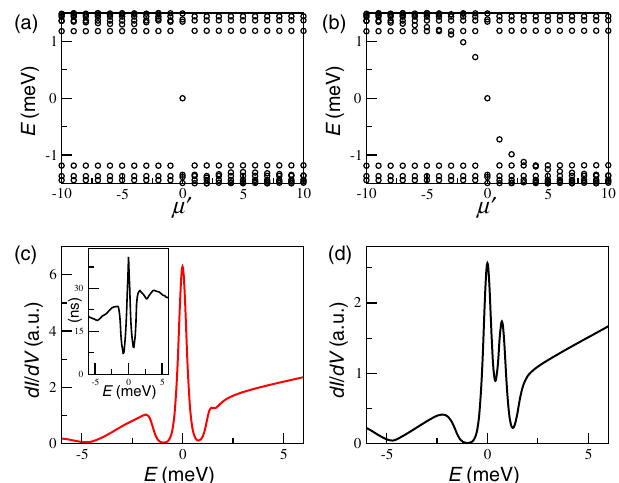
FIG. 3. The low-energy spectrum of the TSS coupled to (a) the QAV induced by the magnetic ion [see Figs. 2(e) and 2(f)], showing an isolated MZM, and (b) a conventional magnetic- field-induced vortex without the magnetic ion. The parameters used for the TSS are λ 0 0 ¼ m 0 0 ¼ 6 . 6 meV. (c) The calculated tunneling conductance (local density of states) at the QAV center. Inset: STM tunneling conductance at the excess Fe site in Fe(Te, Se) [25]. (d) The tunneling conductance obtained at the center of the magnetic-field-induced vortex in (b), showing multiple CdGM vortex core states. Calculated conductance spectra are broadened by a temperature T ¼ 1 . 5